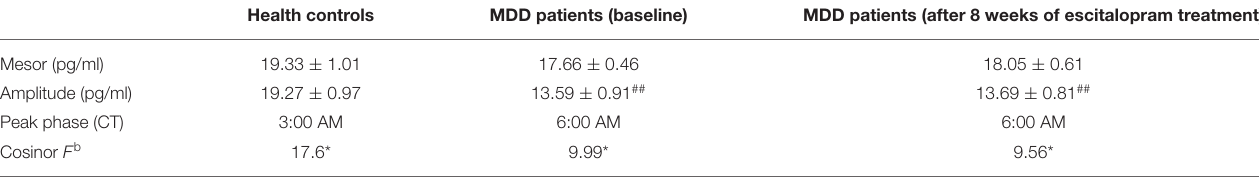
TABLE 2 | Circadian properties of melatonin a .